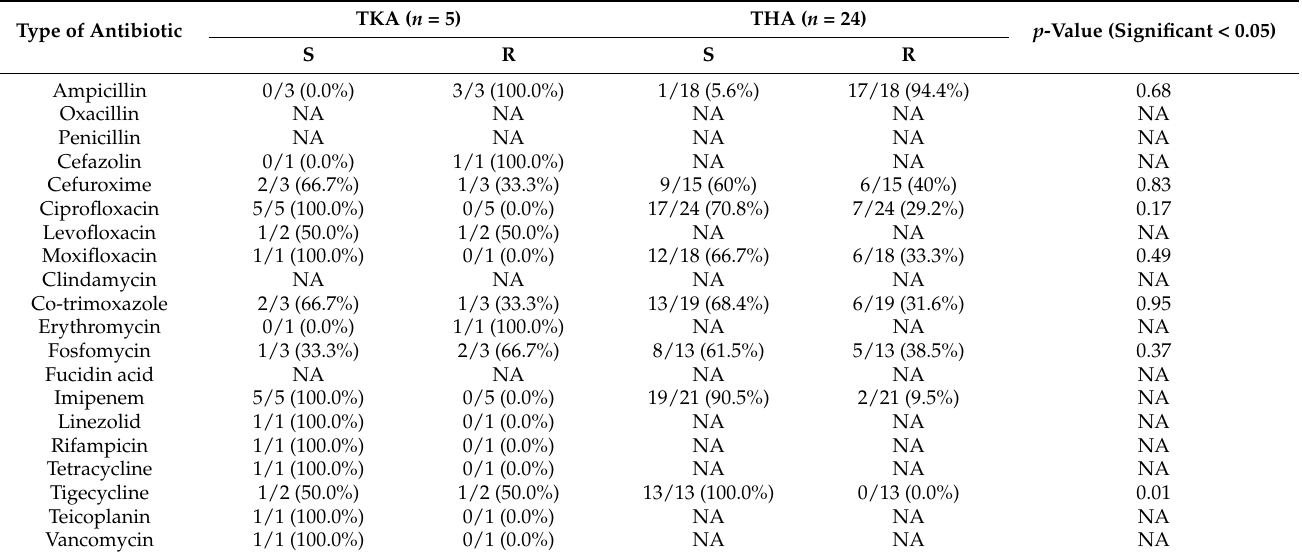
Table 4. Antibiotic resistance of 20 different types of antibiotics to Gram-negative bacteria and its statistical significance, comparing revision TKA and revision